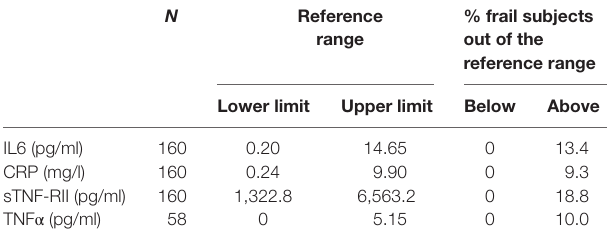
Table 2 | Reference ranges of the immune biomarkers analyzed, calculated on the basis of results obtained in non-frail and pre-frail subjects. N reference % frail subjects range out of